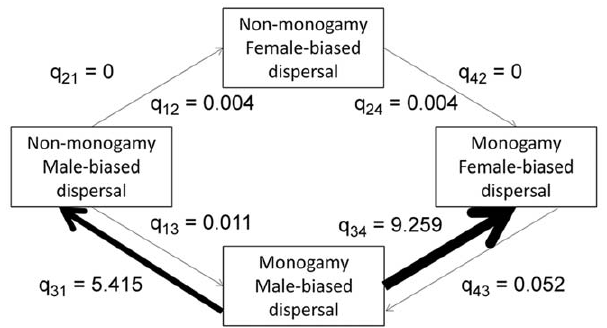
Figure 2. Tree used for the analysis of the avian dispersal distance dataset. Branch lengths are approximated. Social mating system is traced over the branches; social monogamy (the ancestral state) is represented by white branches, social non-monogamy is represented by black branches. The boxes represent character states for sex-biased dispersal, with white boxes for species with FBD and black boxes for species with MBD.